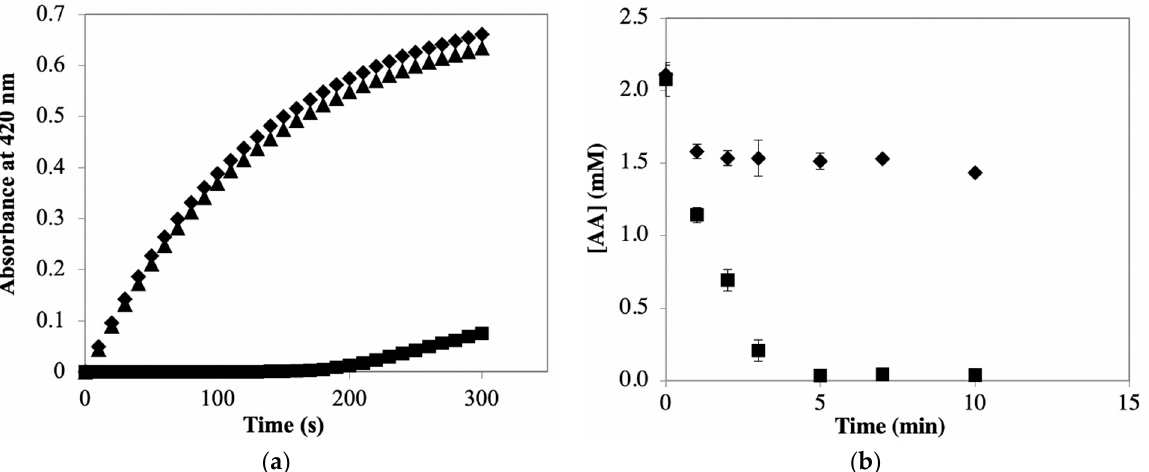
Figure 5. ( a ) Representative time course of product accumulation, depicted as an increase in absorbance, during potato PPO-catalyzed reactions using catechol as a substrate. PPO reaction mixtures were 5 mM catechol solution, in 50 mM sodium phosphate buffer, pH 7.0, containing 0 mM AA ( ◆ ), 0.3 mM AA ( ■ ), or 0.3 mM AA, and 0.45 unit/mL AO ( ▲ ), respectively. Reactions were initiated by adding 0.1 mL semi-purified PPO preparation to 2.2 mL reaction mixture described above. ( b ) Time courses of AO-catalyzed oxidation of AA in PPOE. AO reaction mixtures contained 2 mM AA and five-fold diluted PPOE. Reactions were initiated by adding 0.3 mL AO solution (final concentration of 3.33 unit/mL) to 1.5 mL reaction mixture. AO reactions were carried out with ( ■ ) and without ( ◆ ) shaking. At specified time, AO reactions were terminated by taking an aliquot of 0.2 mL reaction mixture and adding it to 0.5 mL 0.2 mM HCl solution prior to AA quantification. AA was quantified by ABTS + • reduction assay. Values are means ± standard deviations from triplicate assays. Data points without visible error bars have standard deviations smaller than the designated symbols.